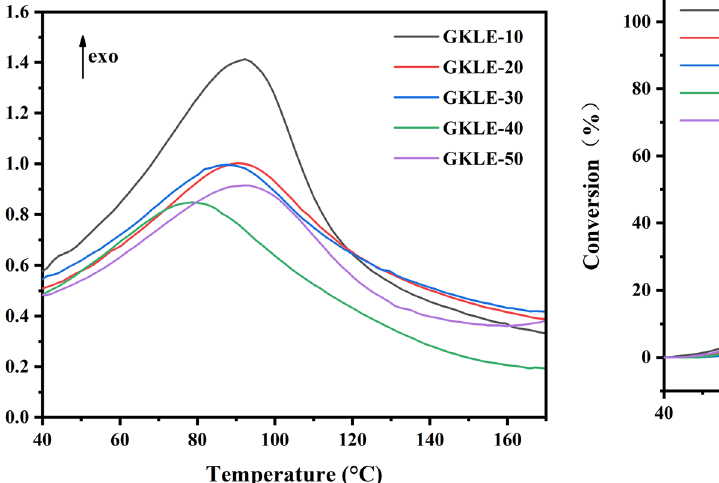
Figure 3: Conversion degree of adhesives with di ff erent